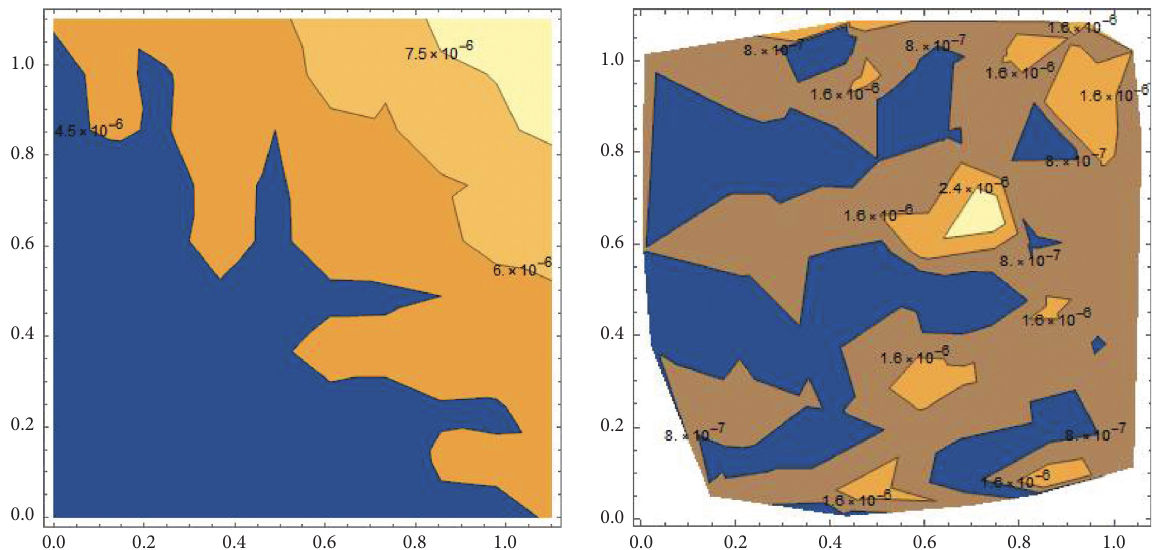
Figure 4: Contour plot errors for the same